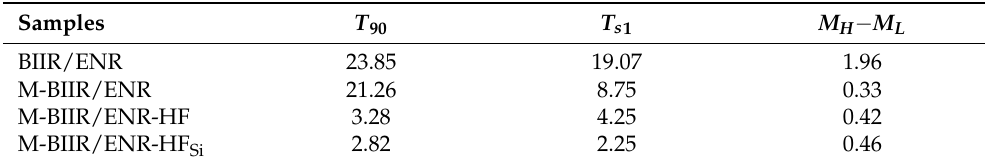
Table 2. Details of chemical crosslink propagation extracted from the cure characteristic curves indicated in Figure 1.